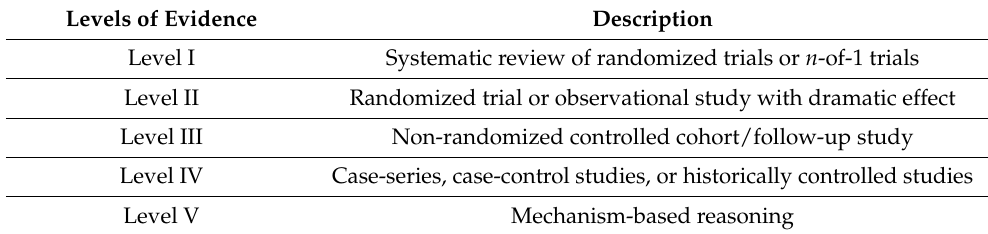
Table 2. Oxford Centre for Evidence-Based Medicine 2011 Levels of Evidence [19].